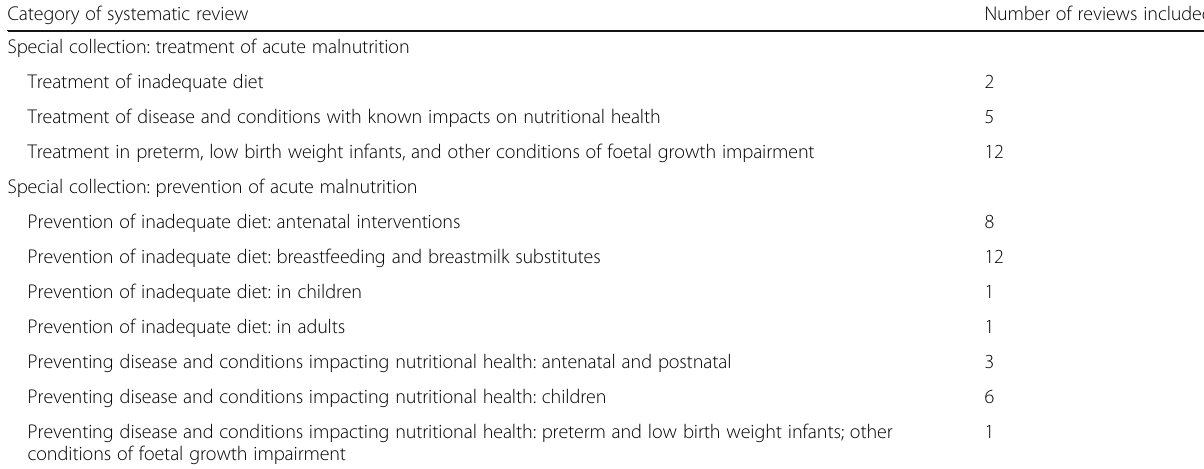
Table 2 Categories of systematic reviews in the Cochrane collection Category of systematic